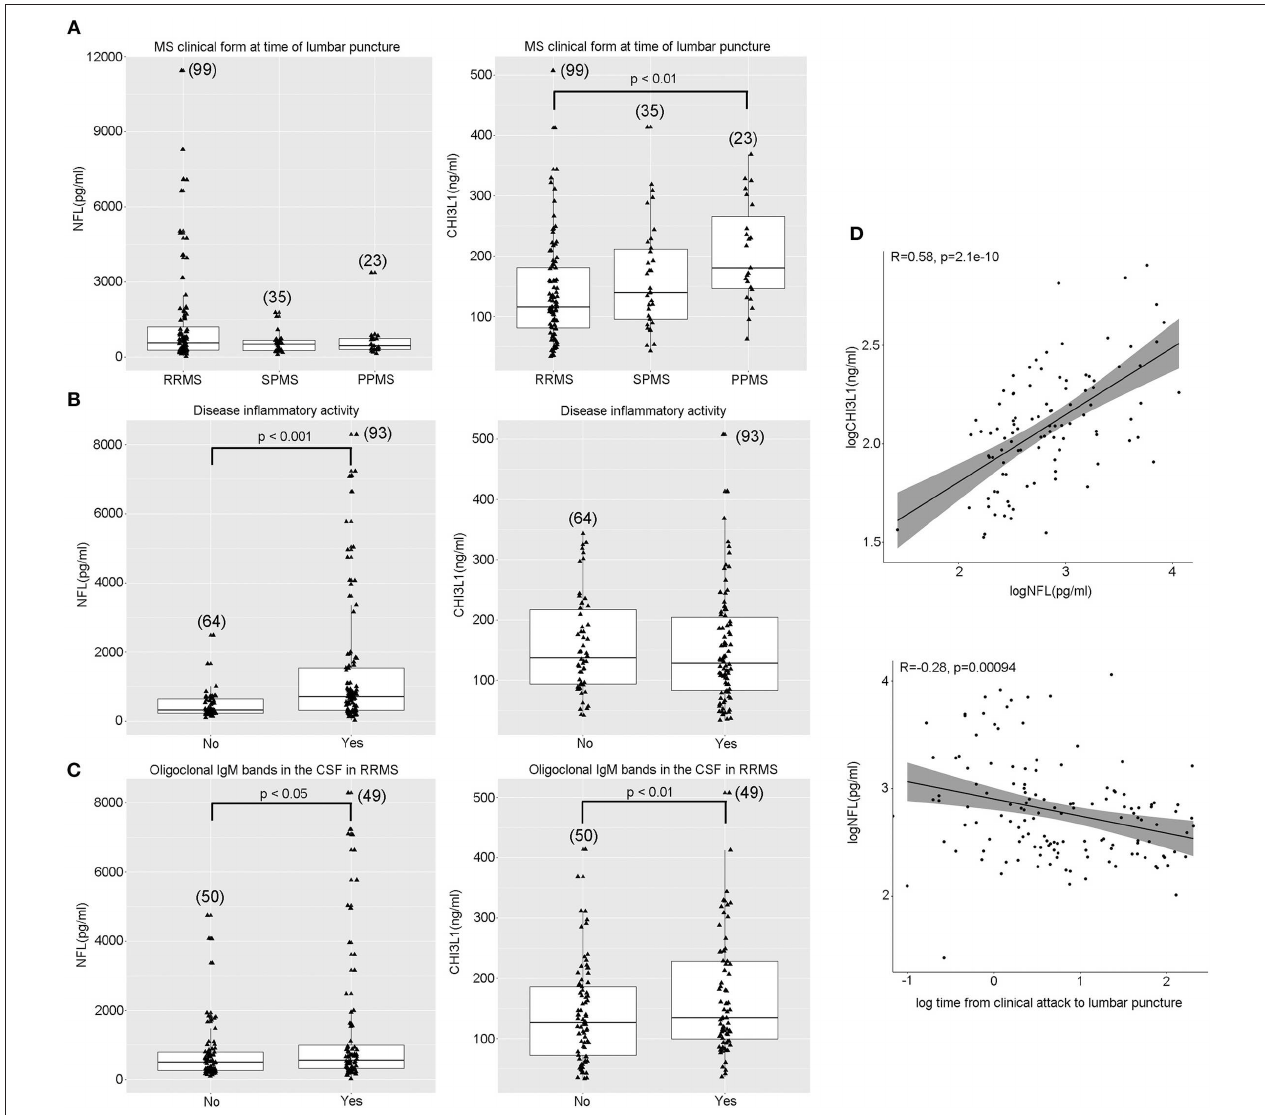
FIGURE 2 | CSF levels of NFL and CHI3L1 in MS in association to phenotype, inflammatory activity, and other influencing variables. (A) Patients with disease activity had higher CSF NFL levels compared to patients without documented disease activity (defined as clinical attack and/or GEL in the MRI within 90 days of CSF collection) (Student T -test p < 0.001). CHI3L1 levels were not different with regards to disease activity (Student T -test p = 0.705). (B) NFL levels were not different between MS forms (ANOVA, p = 0.6) while CHI3L1 were increased in progressive MS compared to RRMS (ANOVA p = 0.01; Bonferroni post-hoc RRMS vs. PPMS p = 0.009). (C) Both NFL and CHI3L1 were higher in the presence of OCMB in the RRMS cohort (Student T -test p = 0.02 and p = 0.004, respectively). (D) NFL and CHI3L1 correlated between each other (Pearson’s r = 0.58; p < 0.001) in the RRMS cohort. NFL levels were lower as time from clinical relapse passed (Pearson’s r = 0.29; p = 0.04). Sample size for each condition is expressed between brackets in the diagram. Student T -test and correlations were performed with log-transformed NFL and CHI3L1. NFL, neurofilament light chain; CHI3L1, chitinase-3-like-1; RRMS, relapsing-remitting multiple sclerosis; SPMS, secondary progressive multiple sclerosis; PPMS, primary progressive multiple sclerosis. GEL, gadolinium-enhanced lesions; CSF, cerebrospinal fluid; MRI, magnetic resonance imaging.